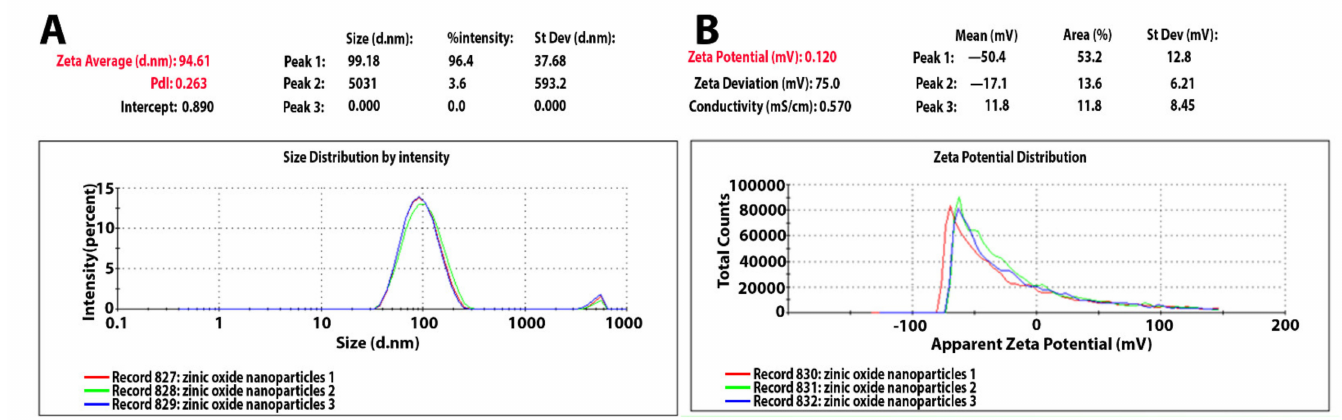
Figure 2. ( A ) Zetasizer of ZnO-NPs. ( B ) Zeta potential of ZnO-NPs.